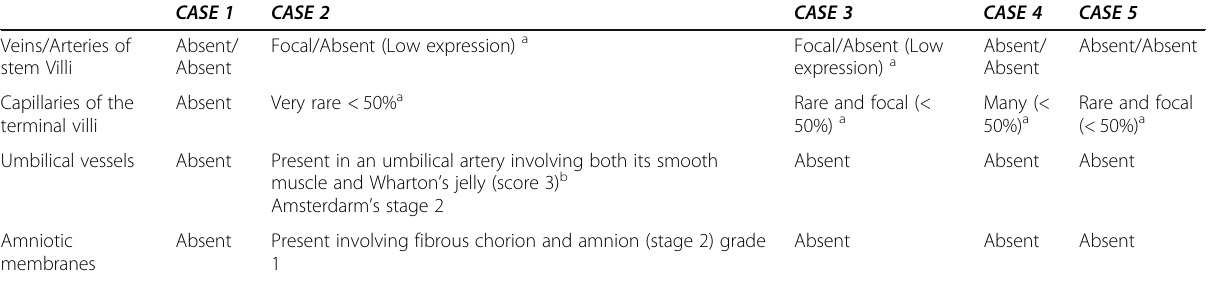
Table 4 Results of CD 15 immunoreactivity to evaluate inflammatory response and risk for intra-uterine foetal